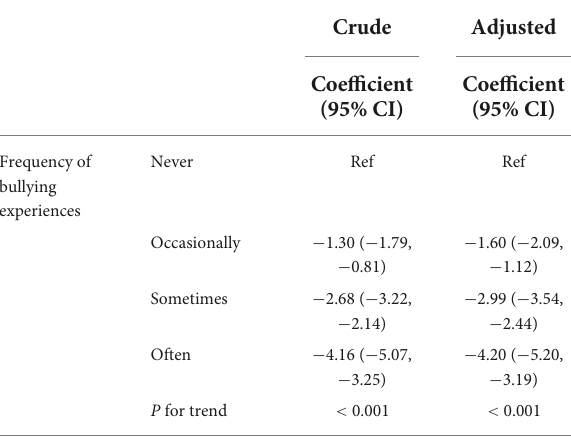
TABLE 3 Association between the frequency of bullying experiences and self-esteem